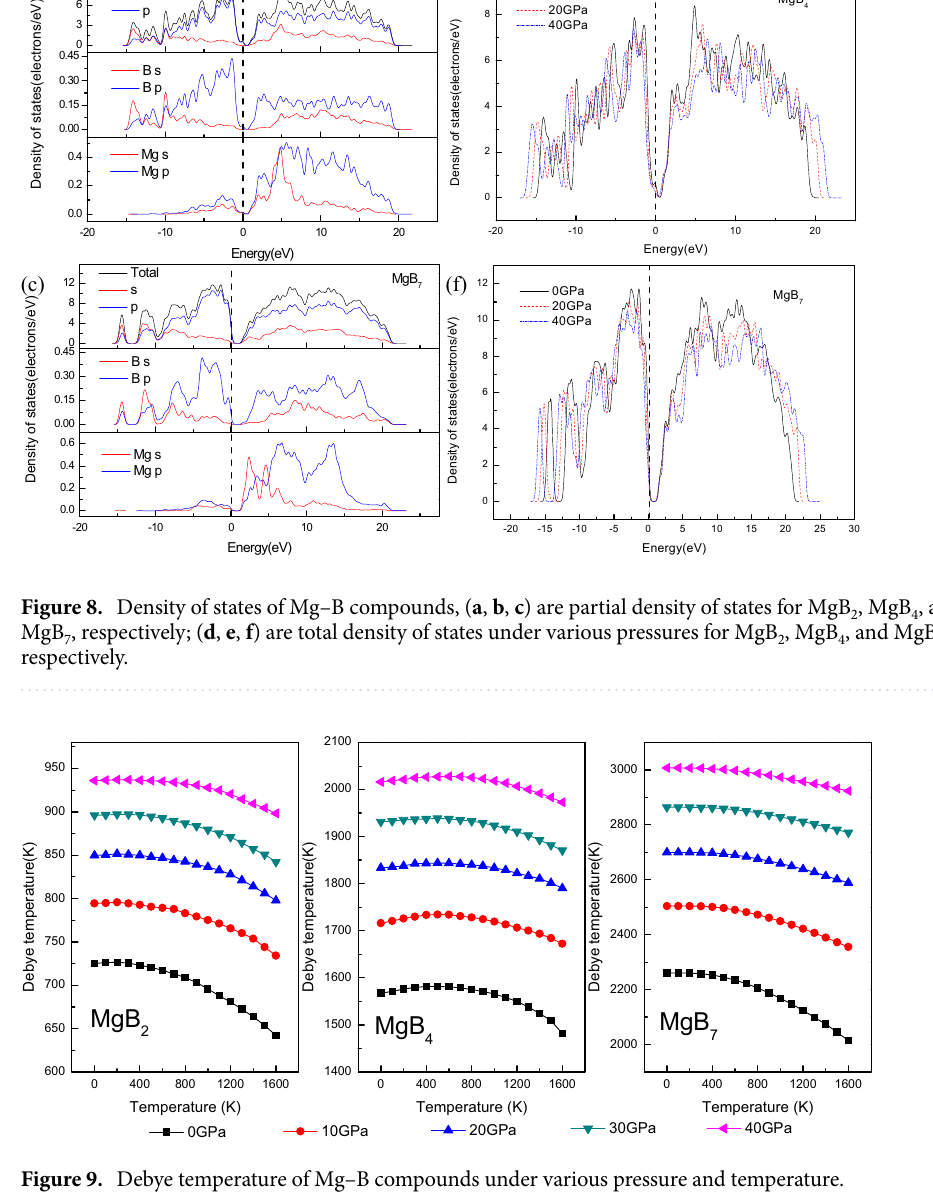
200 K. Simultaneously, the ΘD of the Mg–B compounds from low to high could be rowed as the following order: MgB 2 < MgB 4 < MgB 7 , when all the compounds were under the same temperature and pressure conditions. Figure 10 shows the temperature and pressure dependence of the volumetric thermal expansion coefficient α of the Mg–B compounds. The thermal expansion coefficient is defined as α = 1 V ∂ V ∂ T , and the thermal expan- sion coefficient α increased with an increase in the pressure and the temperature. Although α was linear with